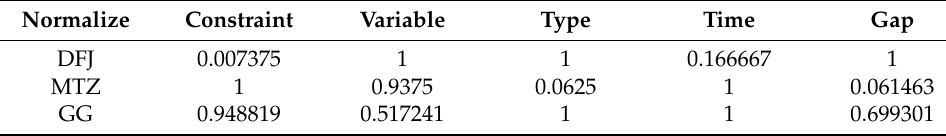
Table A1. Normalized decision matrix.